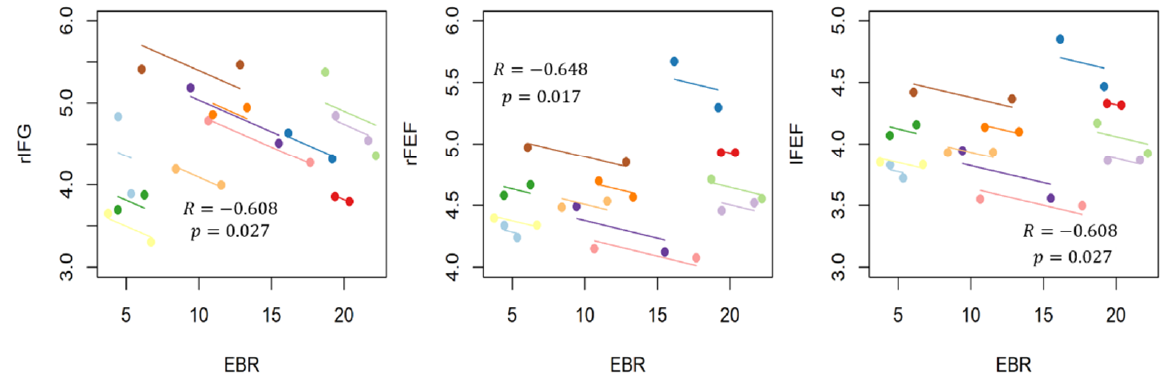
Figure 10. Results of repeated measures correlation between blink parameter Eye Blink Rate (EBR) and the activity of those ROIS which have shown significant modulation of their activity, i.e., rIFG, lFEF, and rFEF in the theta band. The ROIs provided significant modulation of their strength (i.e., lVIS in the alpha band) and participation index (i.e., participation out in alpha band of rIPS) have been